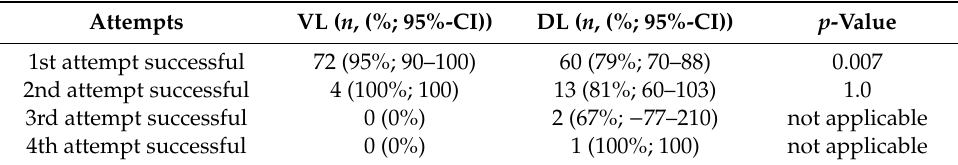
Table 3. Number of attempts for VL and